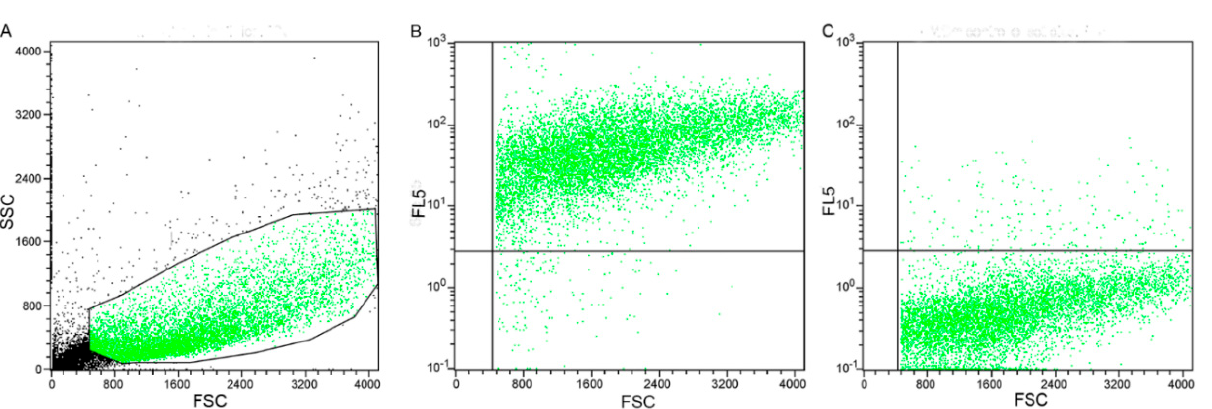
Figure 5. Flow cytometry for TFR-1. Flow cytometry performed on FMCm. ( A ) Morphological scatter plot (forward scatter, FSC; side scatter, SSC), showing cells with a cloud-shaped distribution; ( B ) scatter plot of FSC against FL5, showing cells positive for TFR-1; ( C ) scatter plot of FSC against FL5, i.e., the negative control, showing cells negative for TFR-1.